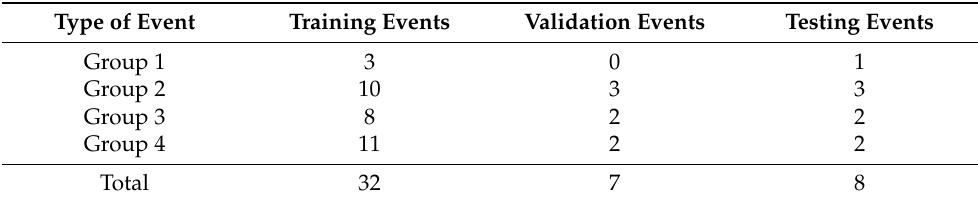
Table 2. Number of events in training, validation, and testing sets for each type of flood